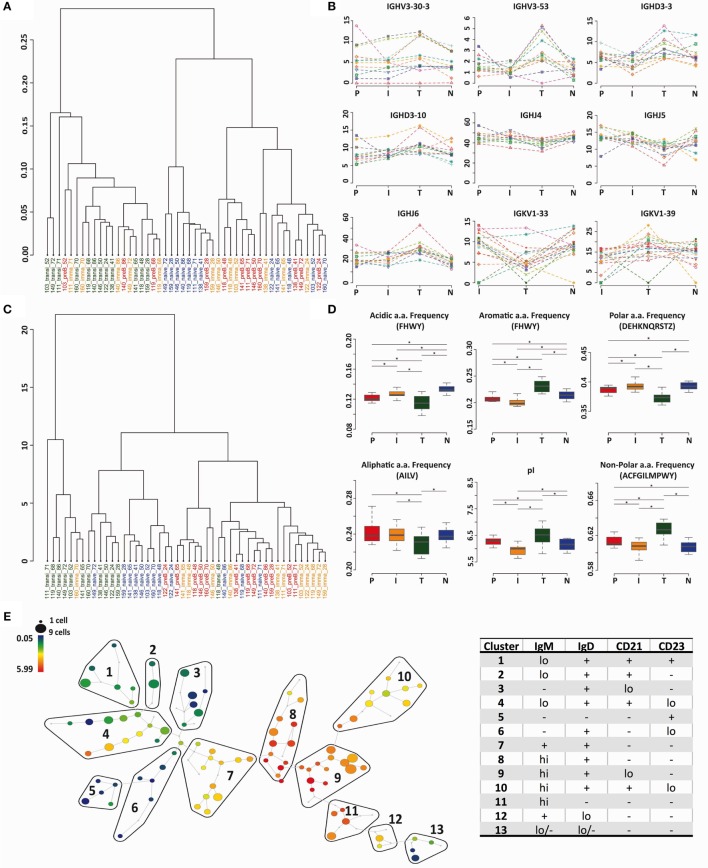
Transitional cells have a unique heavy chain immunoglobulin repertoire. (A,C) Minkowski distance clustering analysis of heavy chain VDJ family usage (A) and CDRH3 Kidera factors for pre-B (P) immature (I), transitional (T), and naïve (N) cells in each donor (C). (B) The frequency of gene use (%) for different cell types in each individual donor for genes that have a distinctive distribution in transitional cells. (D) CDRH3 physicochemical properties in different cell types for properties that have distinctive distributions in transitional cells (*p < 0.05 ANOVA). Values on the y axis are as per the individual graph titles. (E) High-dimensional clustering of CD24hiCD38hi transitional B cells indicates heterogeneity within the transitional population with respect to IgM expression, illustrated as a SPADE plot. Populations numbered 1–13 have been grouped according to the expression of IgM, IgD, CD21, and CD23, as shown in Figure S1 in Supplementary Material.